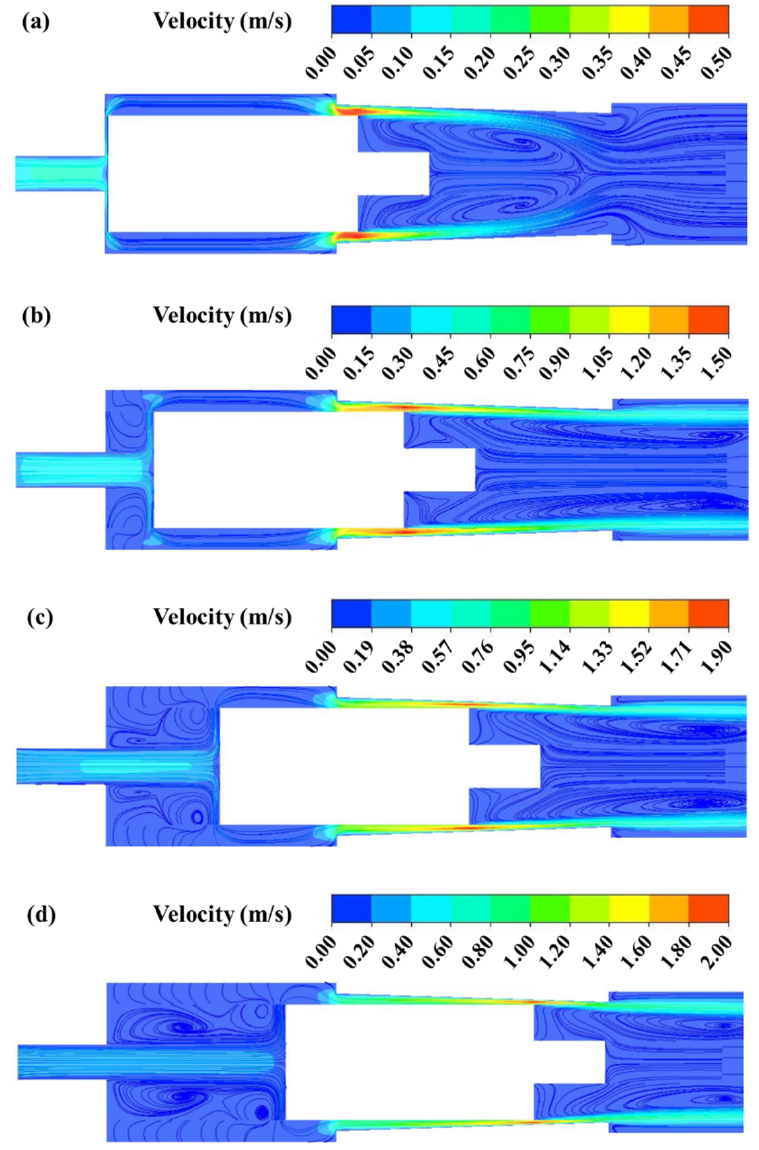
Figure 8. Velocity distribution under varied inlet pressures: ( a ) inlet pressure = 500 Pa; ( b ) inlet pressure = 2000 Pa; ( c ) inlet pressure = 3500 Pa; ( d ) inlet pressure = 5000 Pa.